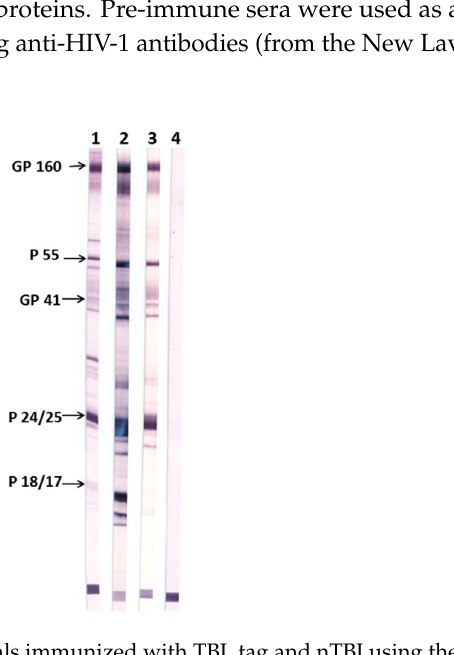
Figure 5. Western blot of sera from animals immunized with TBI_tag and nTBI using the New Lav Blot 1 test system. 1) Positive control from the New Lav Blot kit. 2) Pooled sera of rabbits immunized with TBI_tag. 3) Pooled sera of rabbits immunized with nTBI. 4) A pool of pre-immune sera of rabbits from both